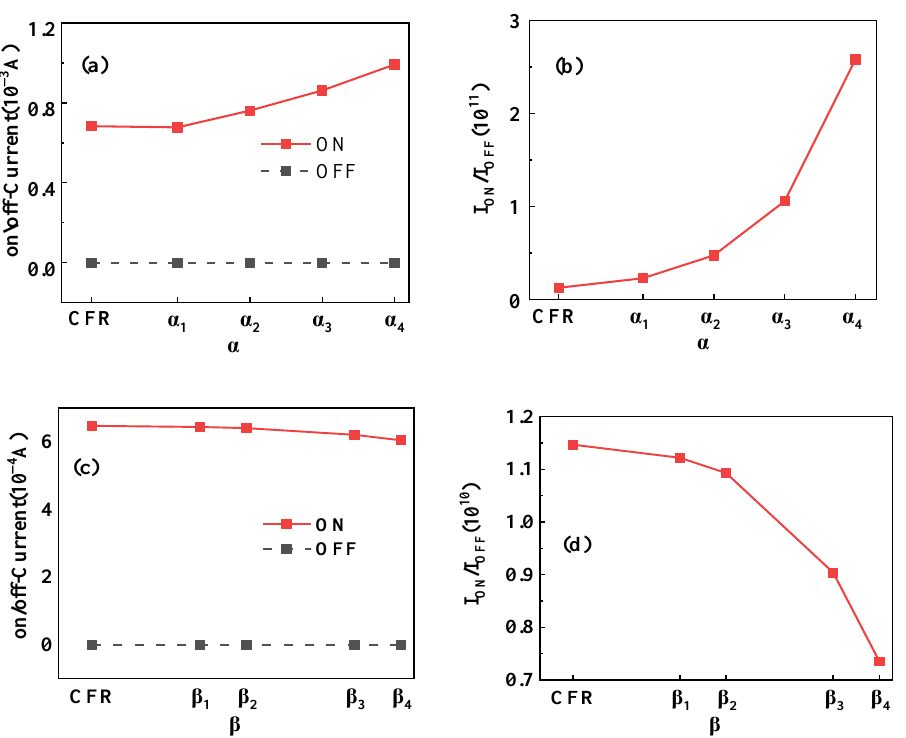
Figure 7. On/off current and on/off current ratio of the CFR-NCFET and DFR-NCFET, ( a ) on/off current versus α of FE2, ( b ) on/off current ratio versus α of FE2, ( c ) on/off current versus β of FE2, ( d ) on/off current ratio versus β of FE2.